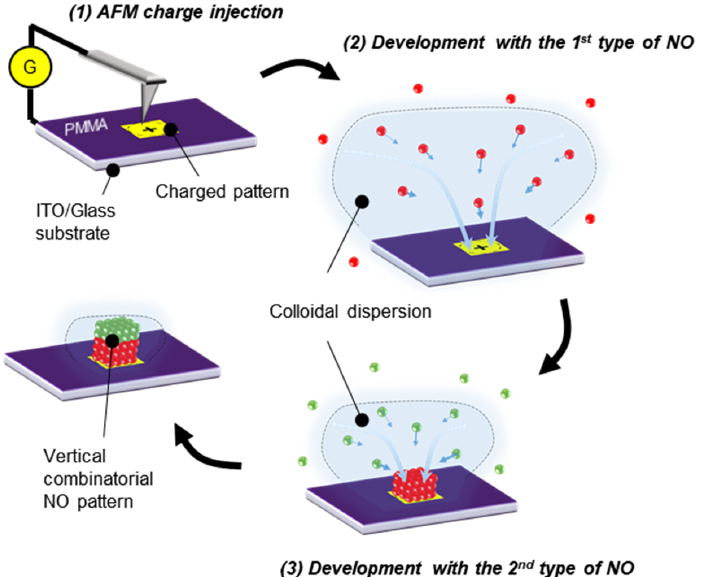
Figure 1. Schematics of the principle of vertical combinatorial patterning of colloidal nano-objects (NOs) on surfaces by AFM nanoxerography, here using two types of NOs (colored in red and green). The blue-colored region symbolized is the electric field extension generated by the charged pattern. This region is reduced over time due to the screening of the charged pattern by the successive directed NO assemblies.